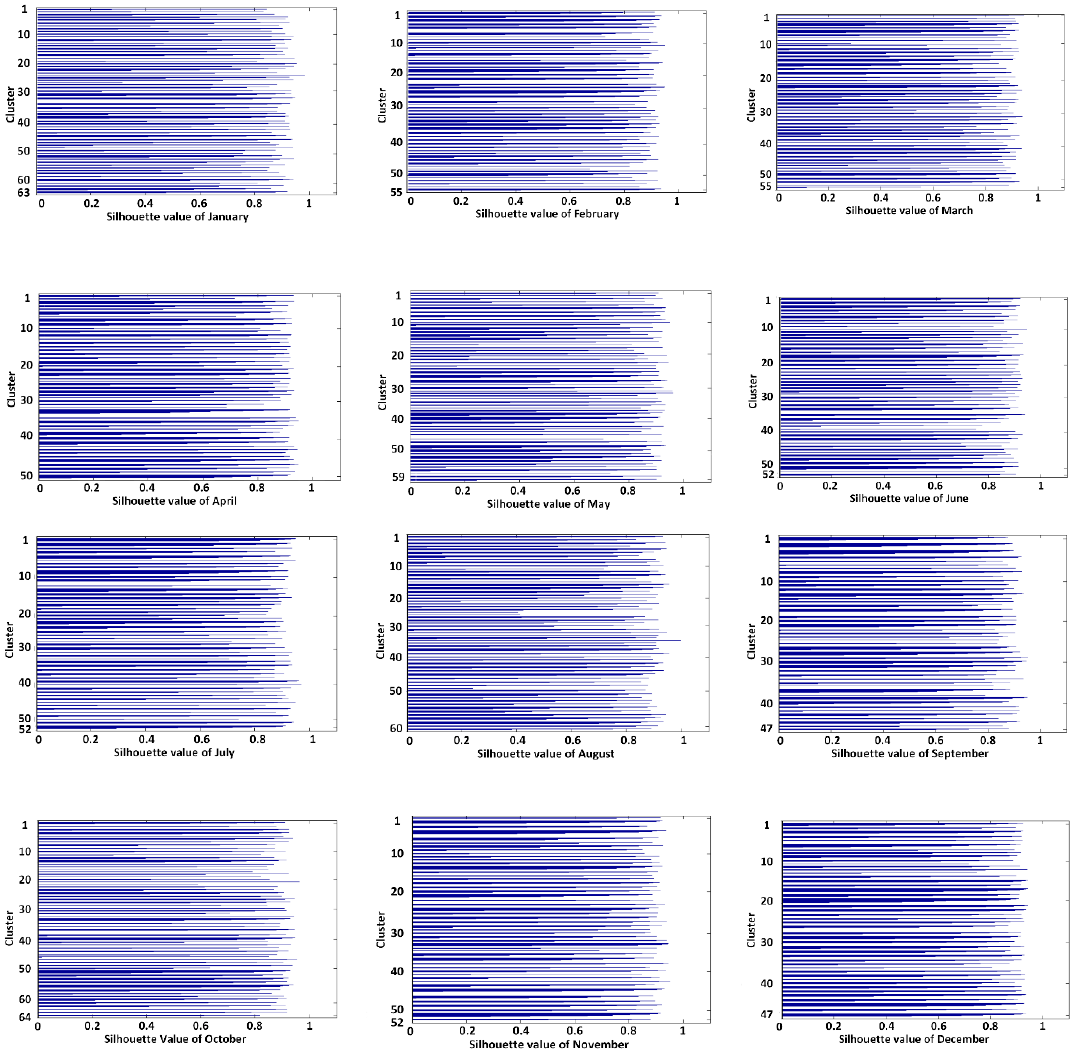
Figure 5. The diagram of silhouette values in each month.